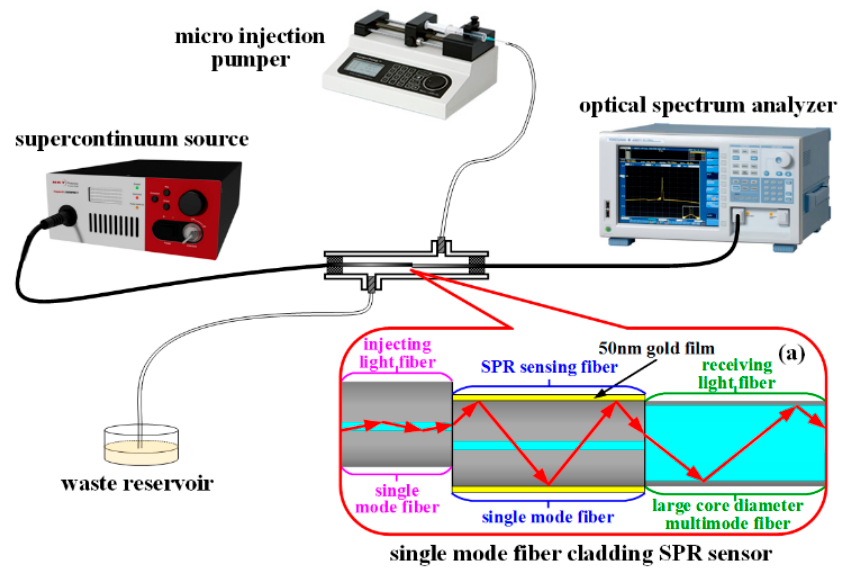
Figure 4. Diagram of the experimental test equipment of the single-mode fiber cladding SPR sensor based on the core-shift welding